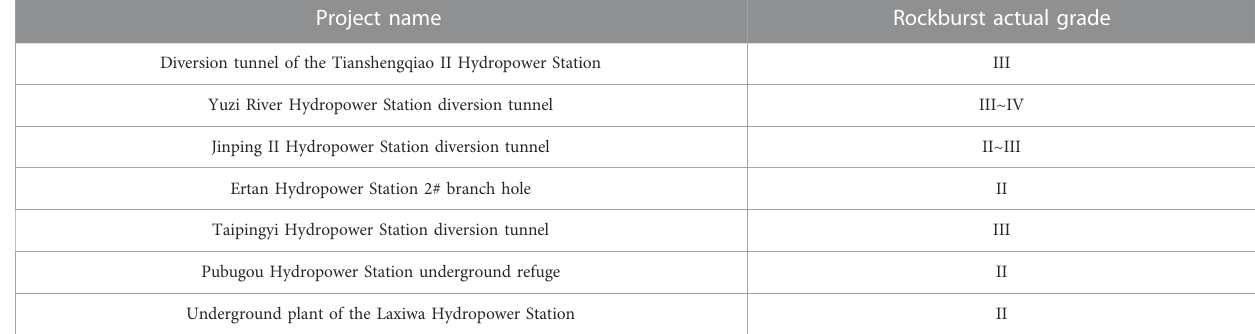
TABLE 9 Sample rockburst actual grade.